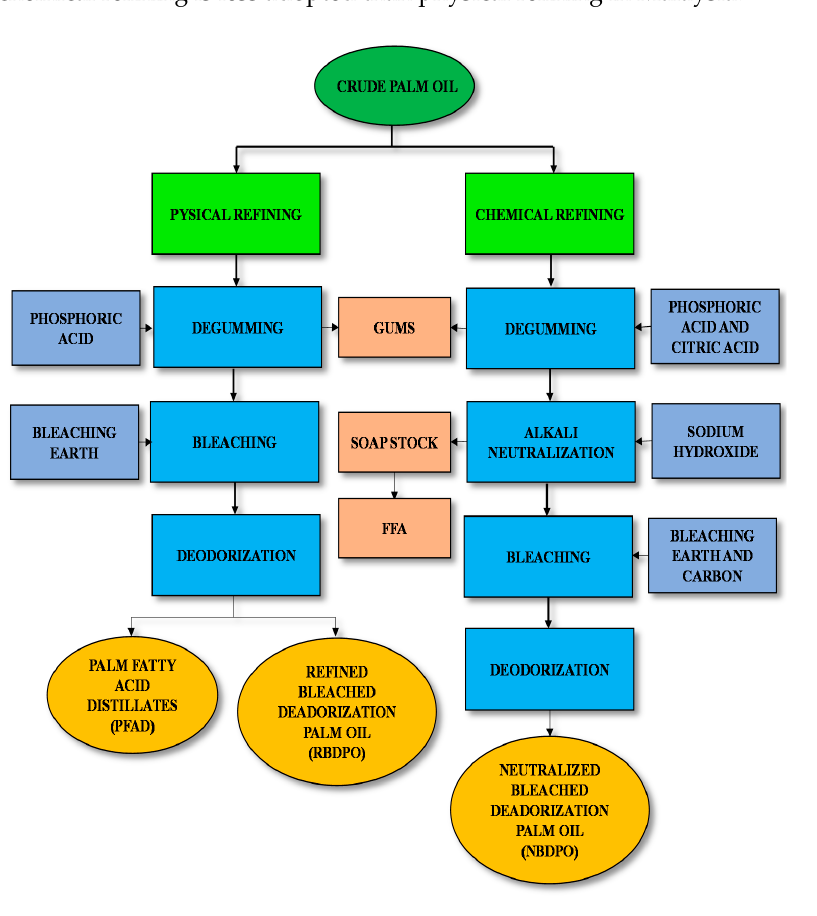
Table 3. PORAM (Palm Oil Refiners Association of Malaysia) standard specifications for refined palm oils.